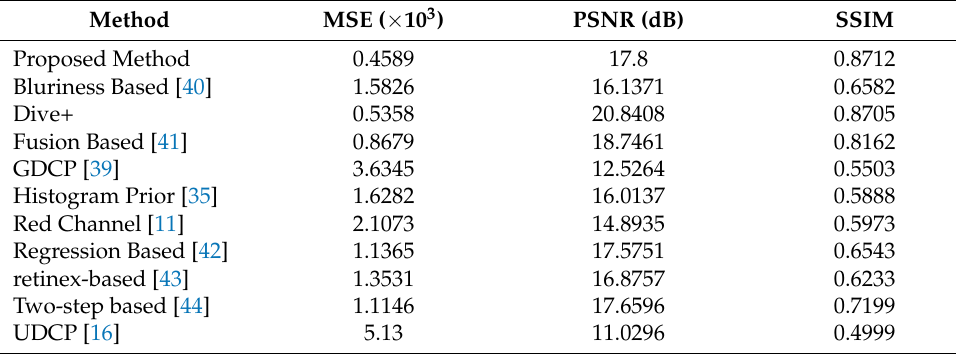
Table 4. Image Quality Reference.